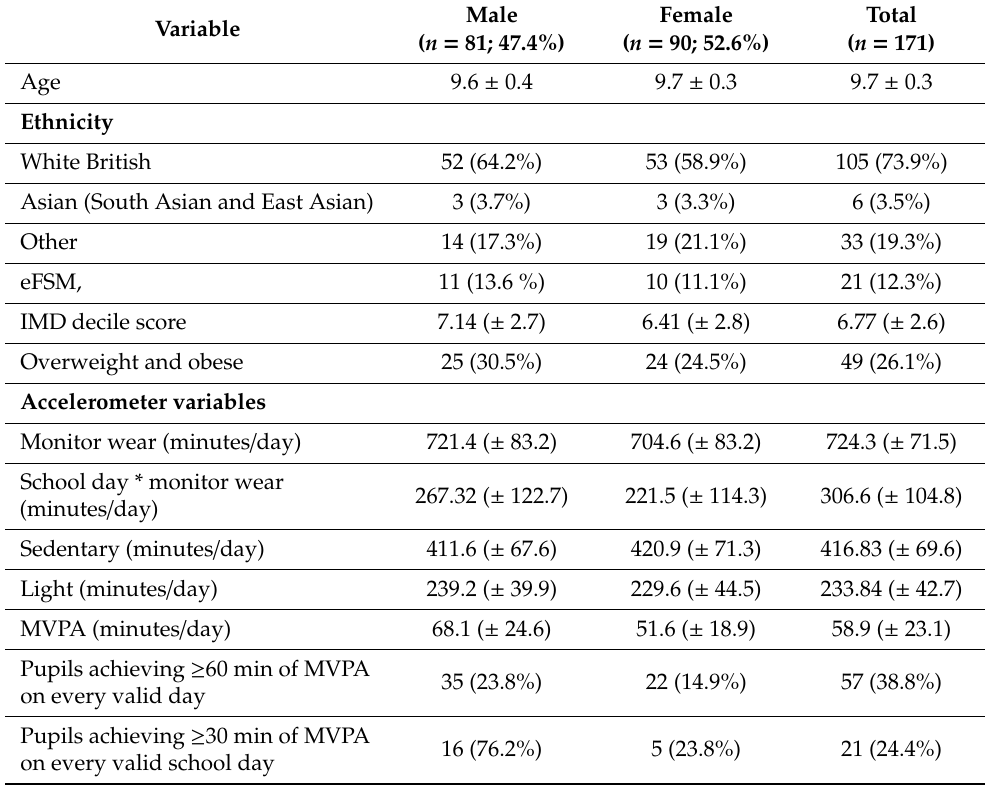
Table 3. Individual level characteristics of pupils participating in Marathon